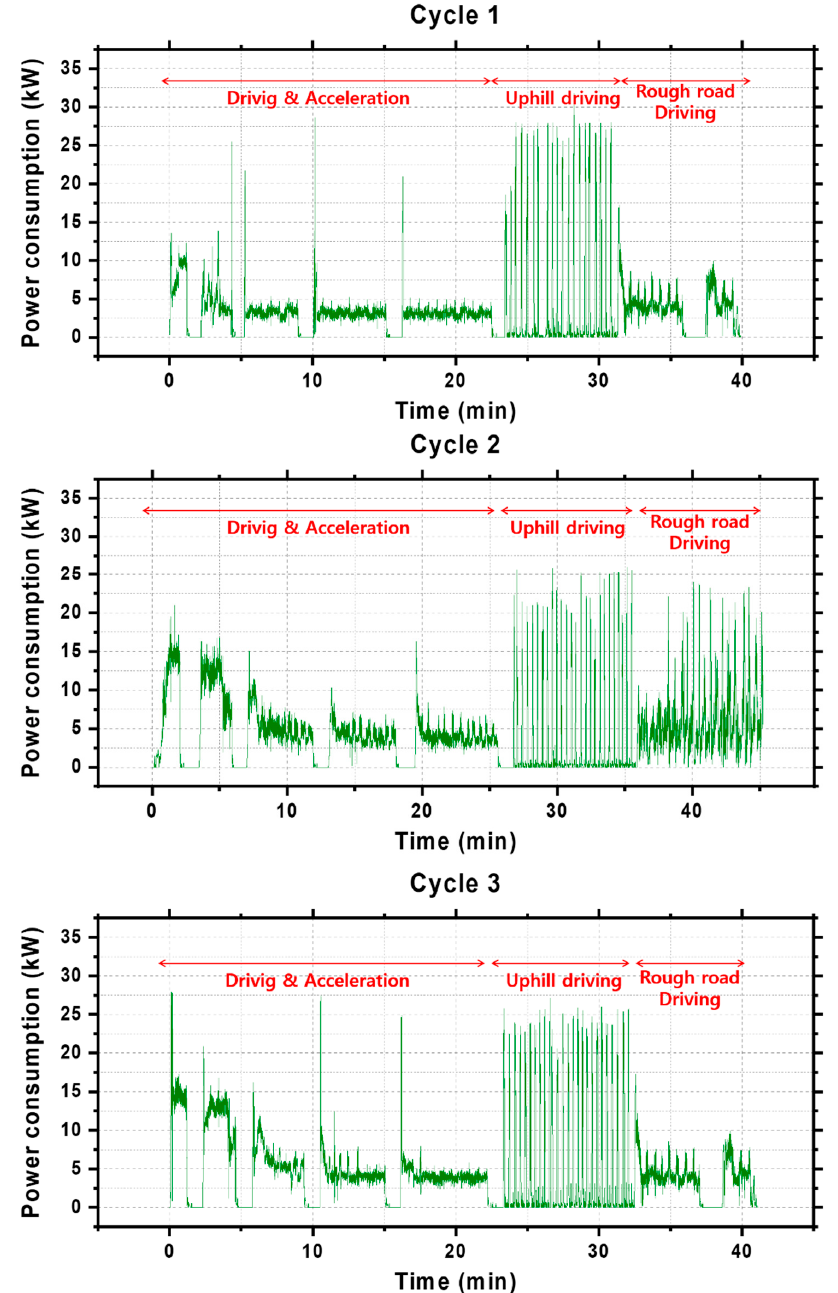
Figure 14. Driving cycle based on actual driving data.